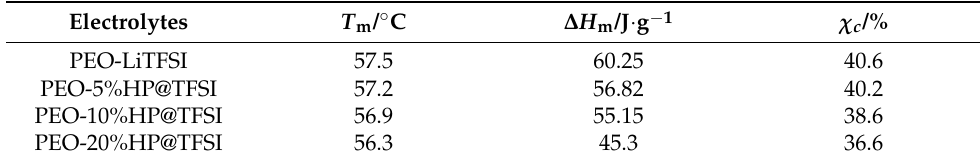
Table 1. DSC results of polymer electrolyte.